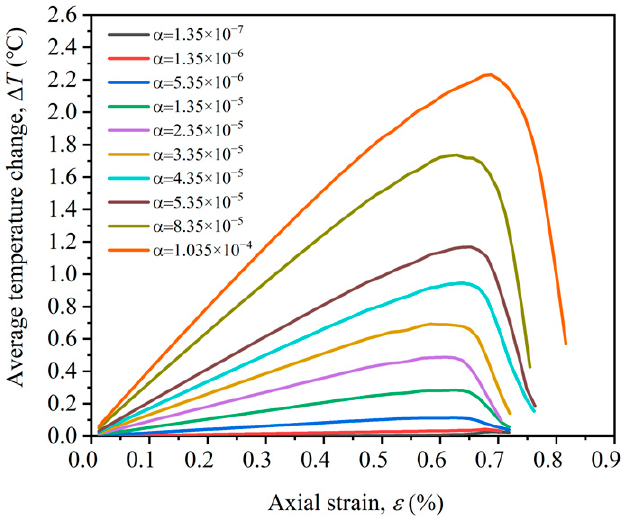
Figure 12. Effect of different coefficients of thermal expansion on average temperature change.